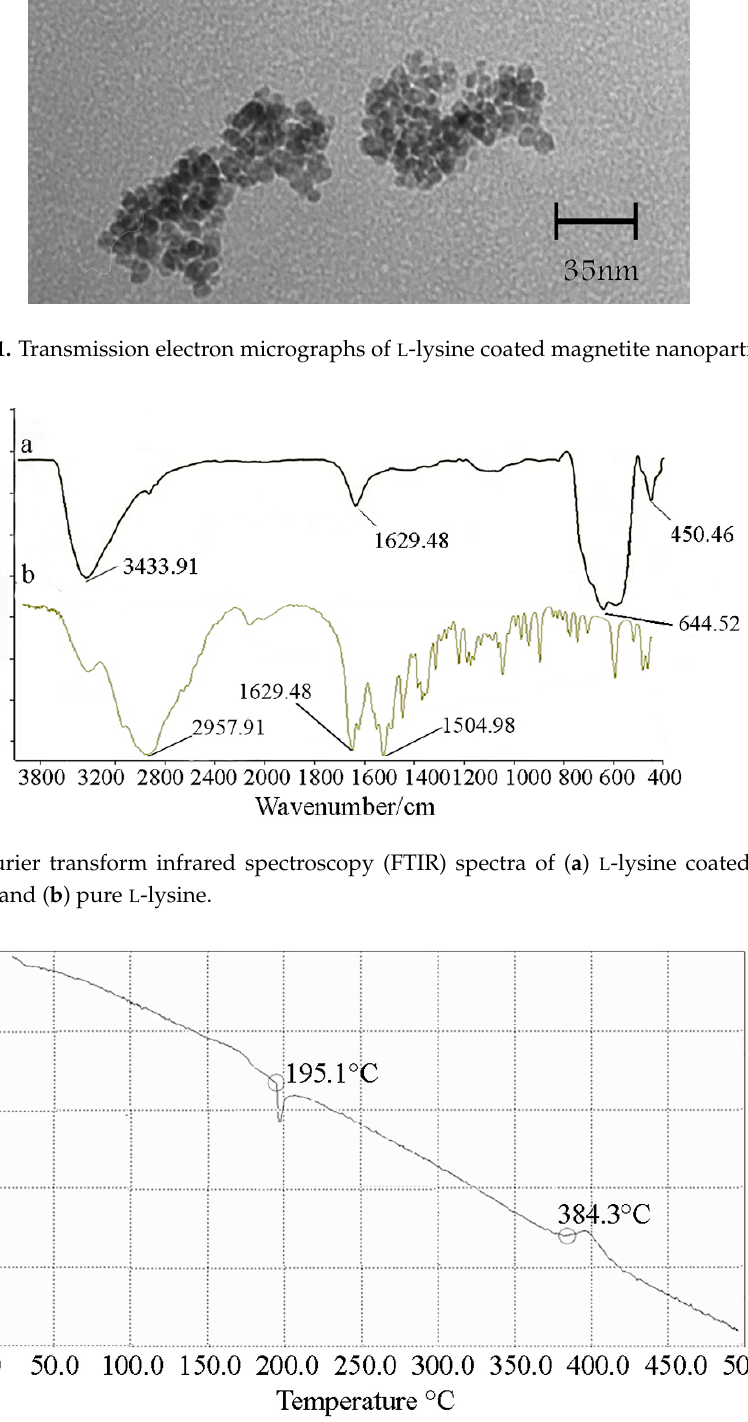
Figure 3. Differential scanning calorimetry (DSC) curves of L -lysine coated magnetite nanoparticles.